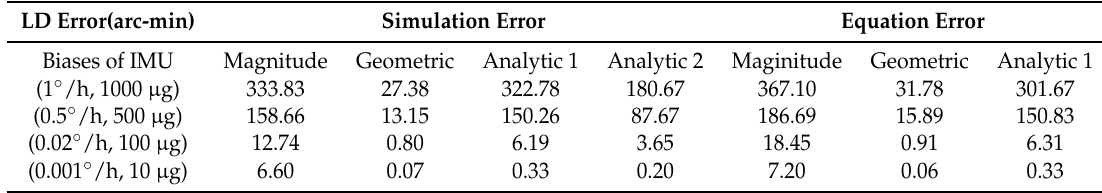
Table 4. The latitude error of different level biases of the IMU.